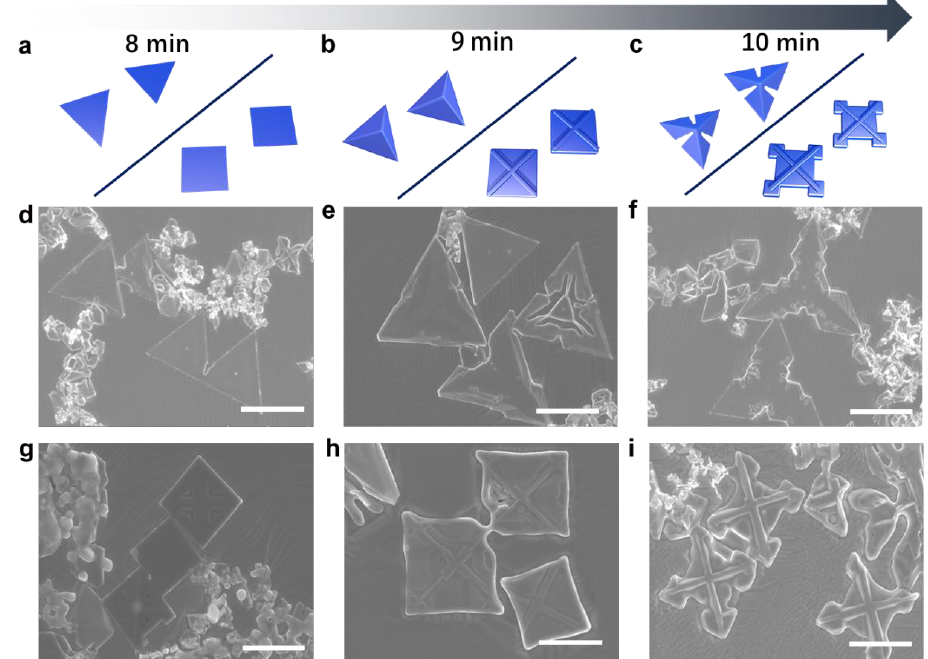
Figure 4. The morphology evolutions of δ -MoN and γ -Mo 2 N domains with increasing growth time. ( a – c ) Schematic diagram of the morphology evolution of two types of Mo x N y . ( d – i ) Typical SEM images of δ -MoN ( d – f ) and γ -Mo 2 N ( g – i ) flakes at various growth times: 8, 9, 10 min. The scale bars are 5μm.